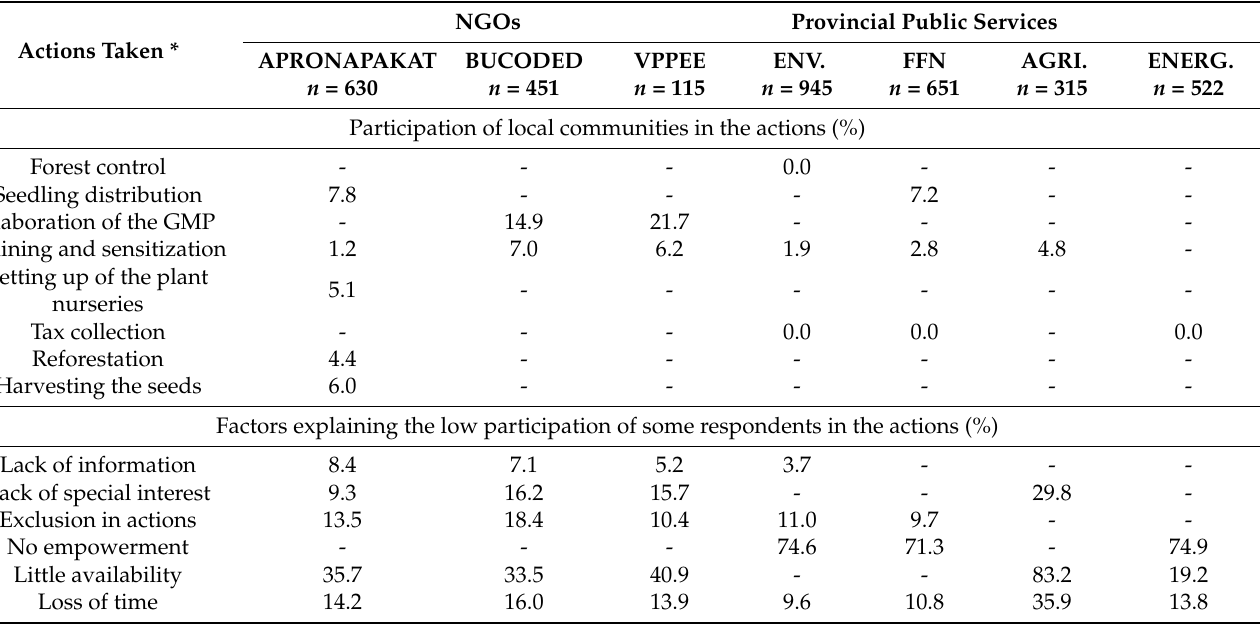
Table 8. Participation of the local communities in the actions carried out by the NGOs and the provincial public services, in the different villages of the rural area of